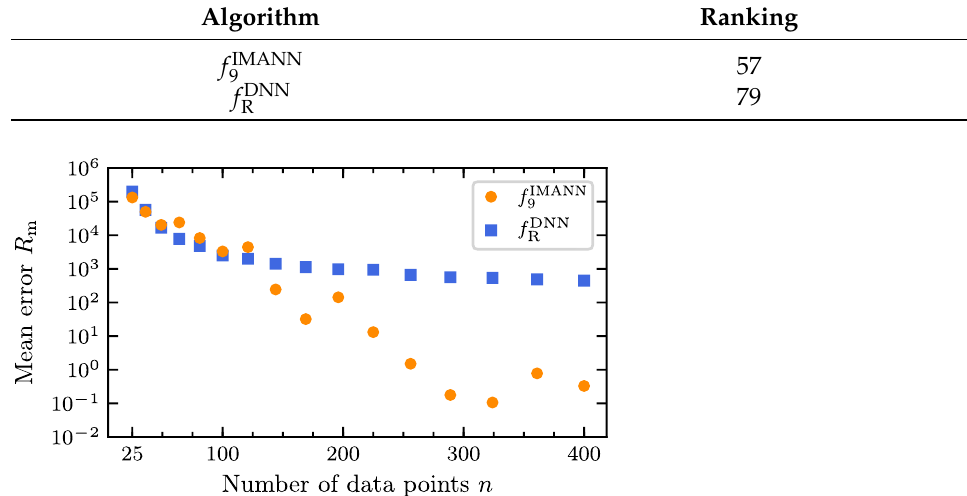
Figure 8. Mean integral squared error R m for problems f 9 and f DNN data